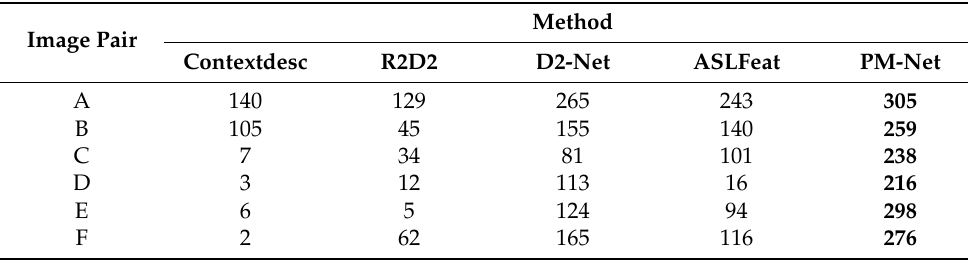
Table 1. Number of correct matching points.